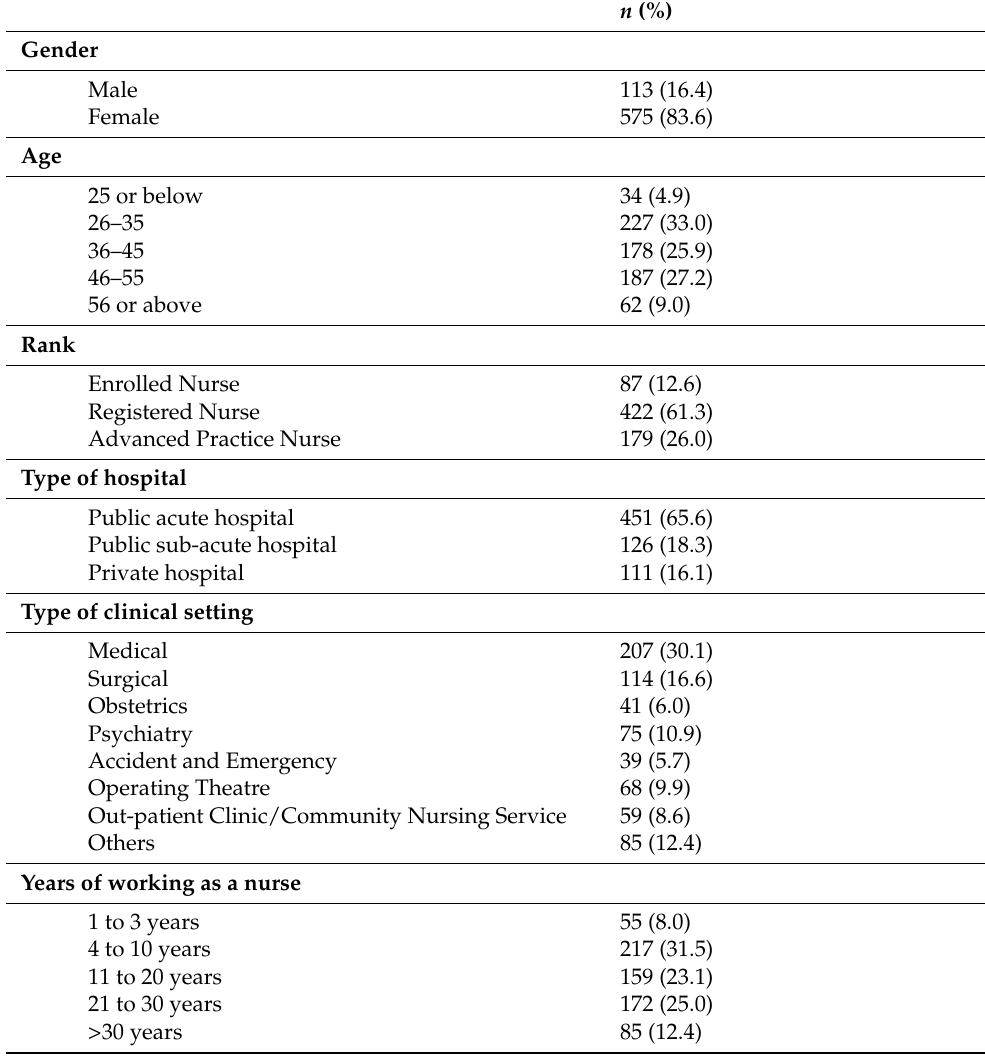
Table 2. Demographic and work-related characteristics of the respondents ( N =